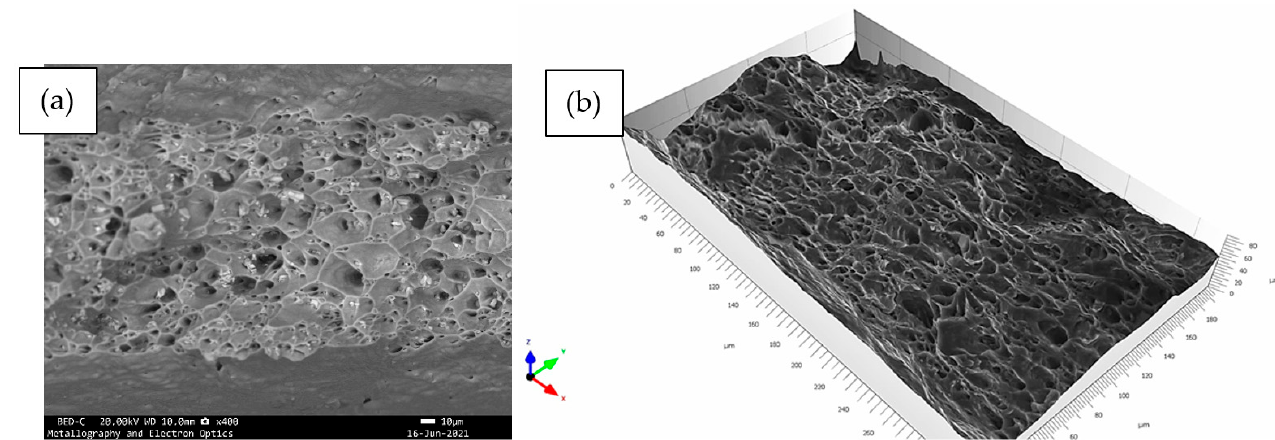
Figure 8. ( a ) SEM fractography and ( b ) indicative 3D reconstruction of surface topography from one or several SEM fractography of sample rx.TR.